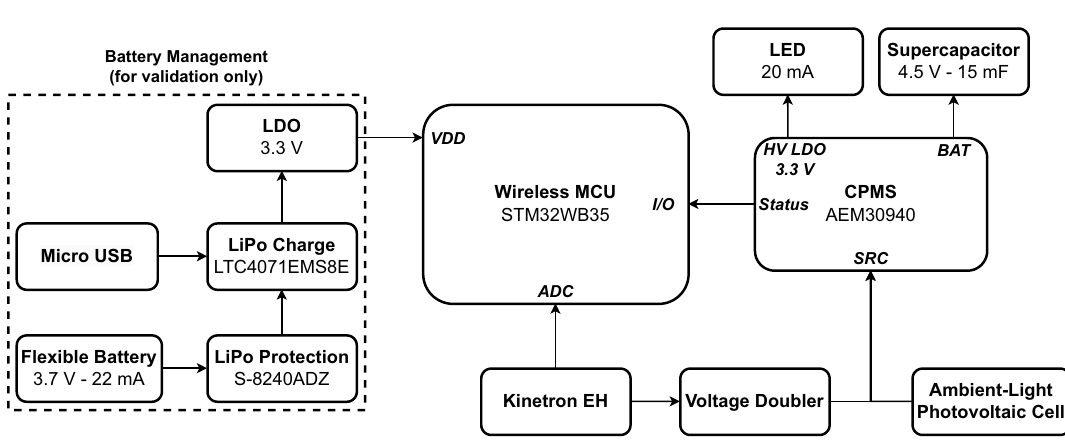
Figure 4. High-level block diagram of the proposed hybrid energy harvesting and power management